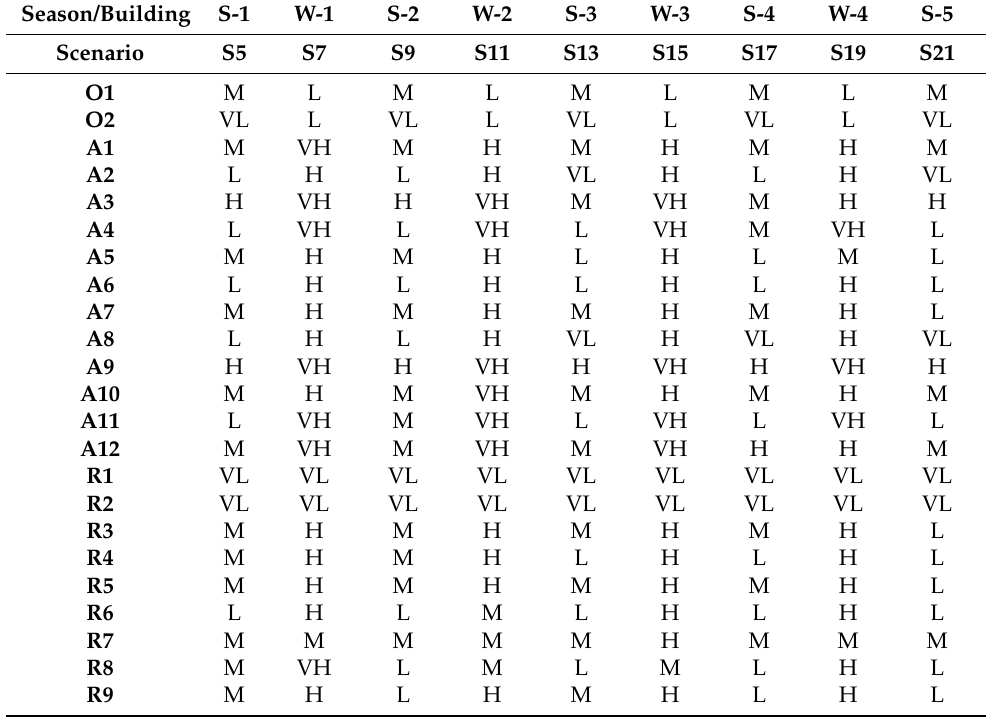
Table 6. Seasonal variation results of carbon preference